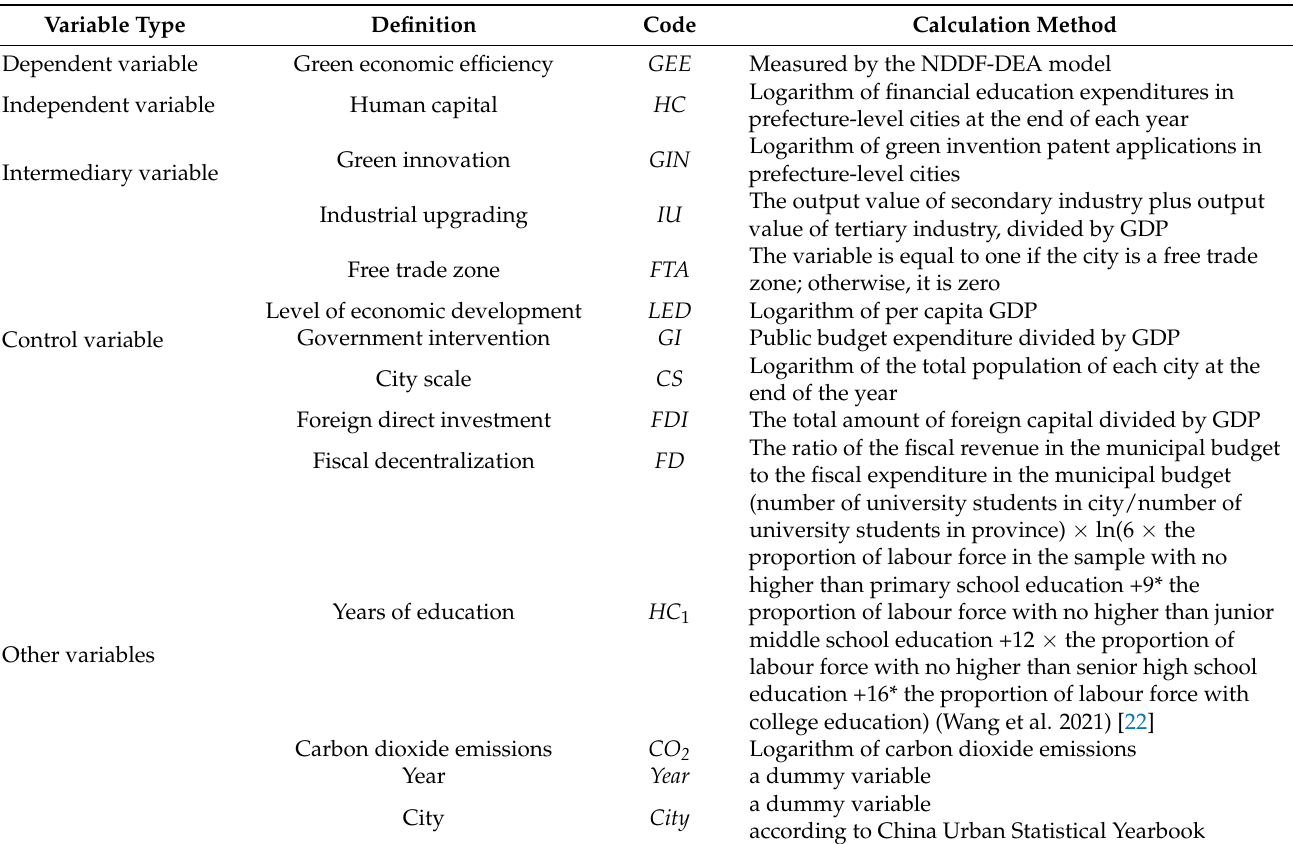
Table 1. Variable definition and calculation